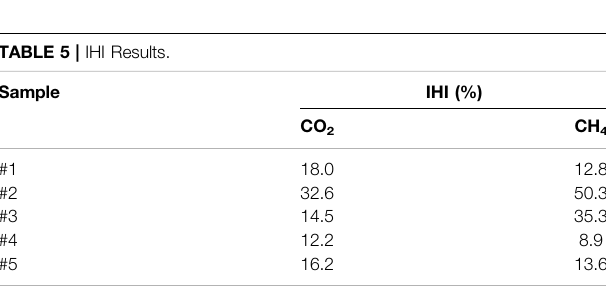
TABLE 5 | IHI Results.